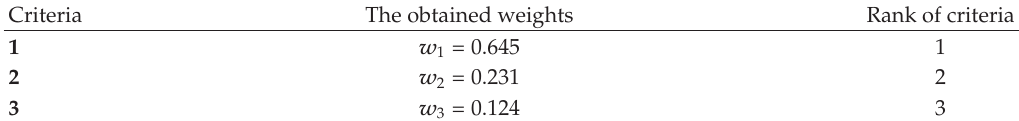
Table 3: The result of proposed method for Example 2 (cid:2) see Section 4.2 (cid:3)